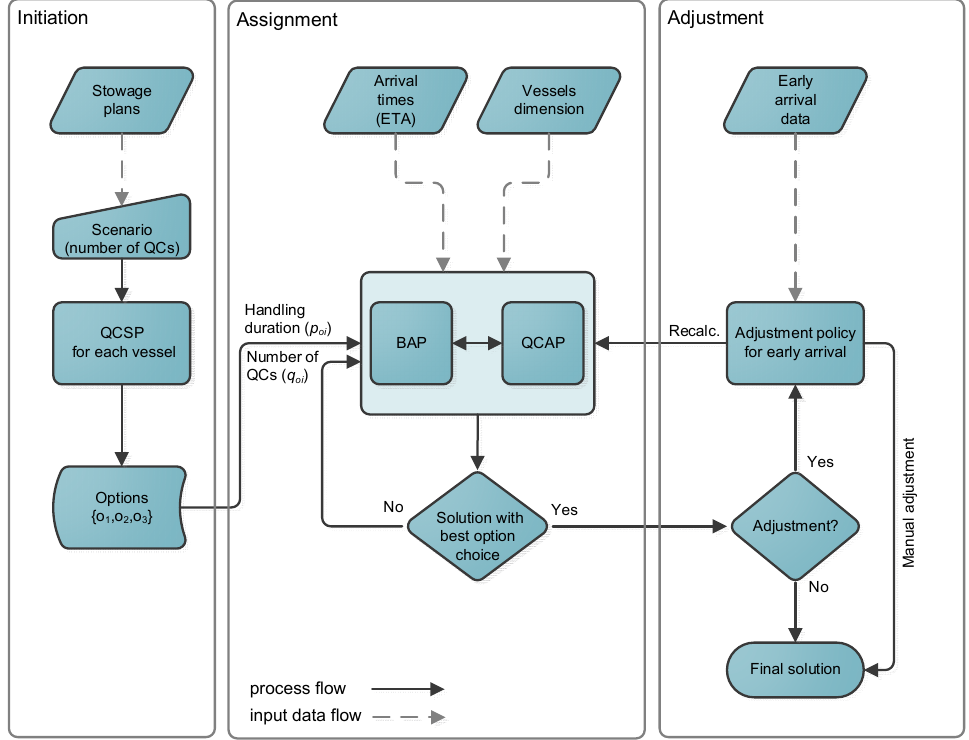
Figure 4. The optimization process for seaside operations on CT.